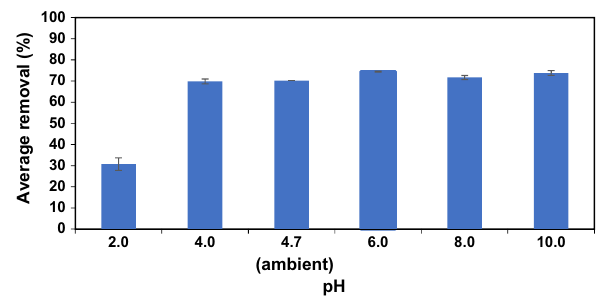
Fig. 2 The effect of medium pH on the adsorption of 100 mg L −1 MV2B on